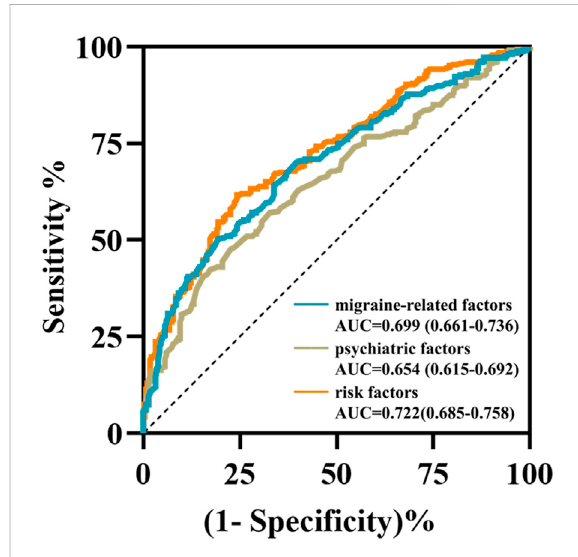
FIGURE 1 The receiver operating characteristic curves of three prediction models using multivariable logistic regression analysis. The area under the curves of model 1 (migraine-related factors), model 2 (psychiatric factors), and model 3 (six risk factors) were 0.699 (cyan curve), 0.654 (brown curve) and 0.722 (orange curve), respectively.